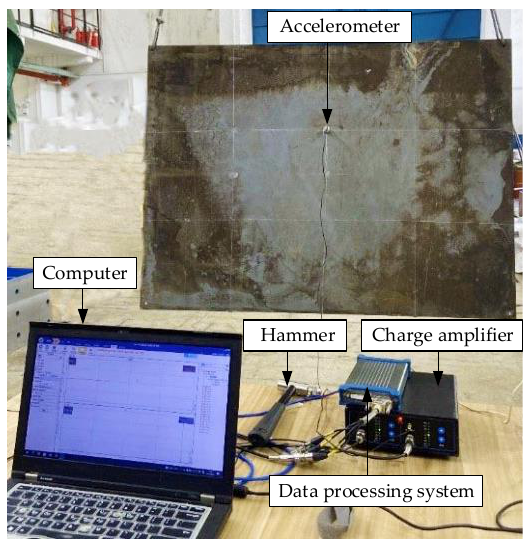
Figure 5. The actual experimental setup of the modal test.